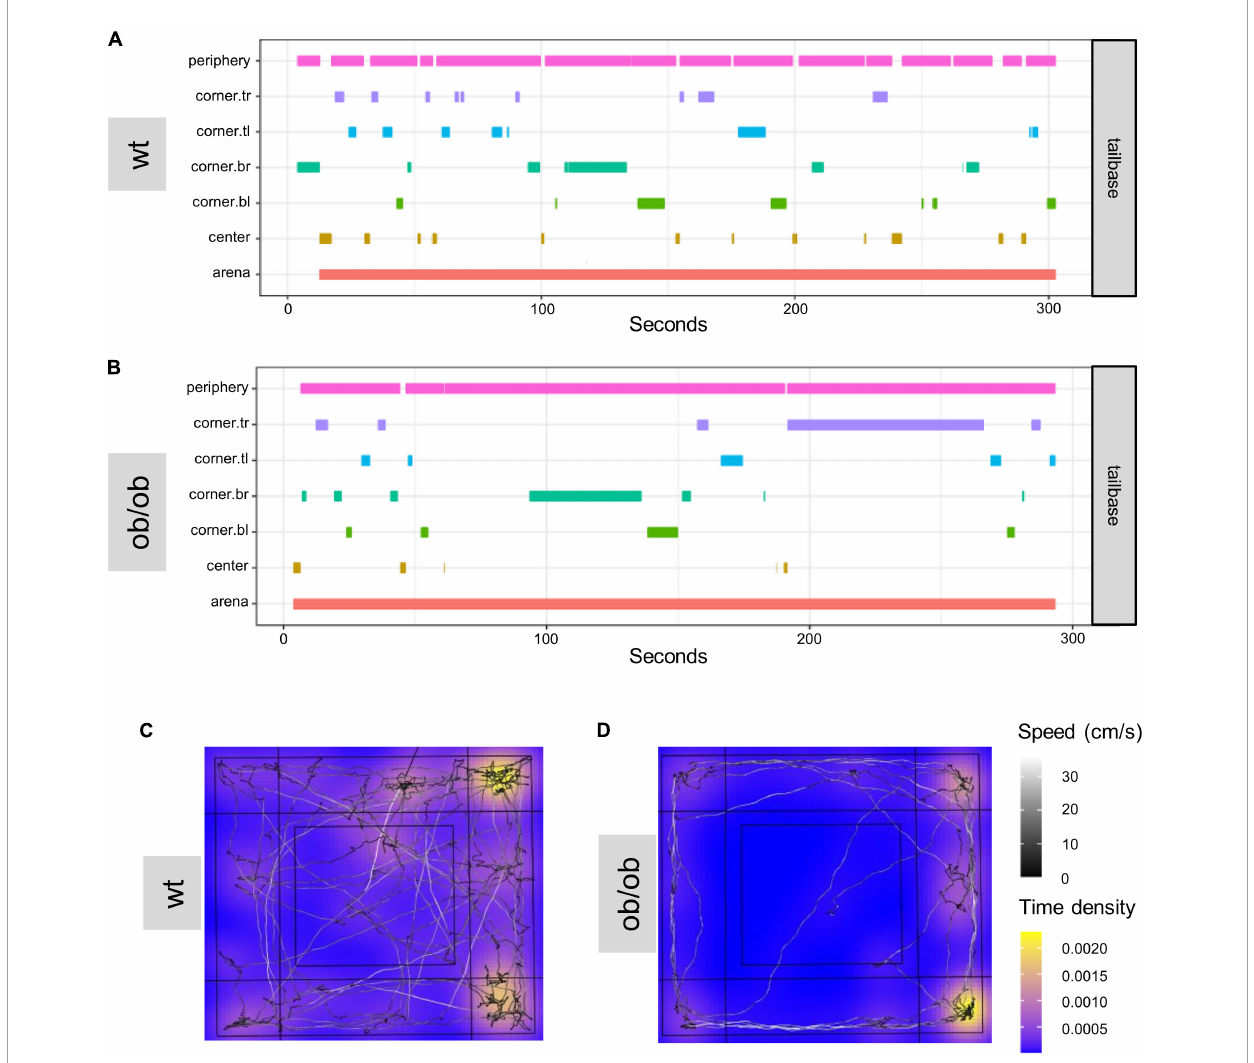
FIGURE7 DeepLabCut (DLC) tracking results analyzed with customized R-script based on DLC-Analyzer. Example of a zone-visit-plot of a wild type [ (A) wt] and an ob/ob (B) mouse in OF. The individual zones show how much time the body part of interest ( Supplementary Figure 2 for labeling of animals in DLC) was tracked in the predefined zones. Heat-maps of the OF test of wild type [wt (C) ], and transgene leptin deficient [ob/ob (D) ] mice. tl, top left; tr, top right; bl, bottom left, br, bottom